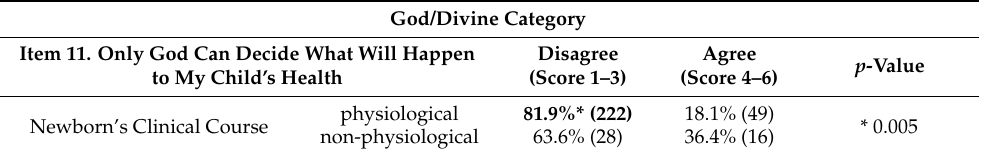
Table 5. Statistically significant correlations between “Divine/God” category and socio-demographic characteristics.